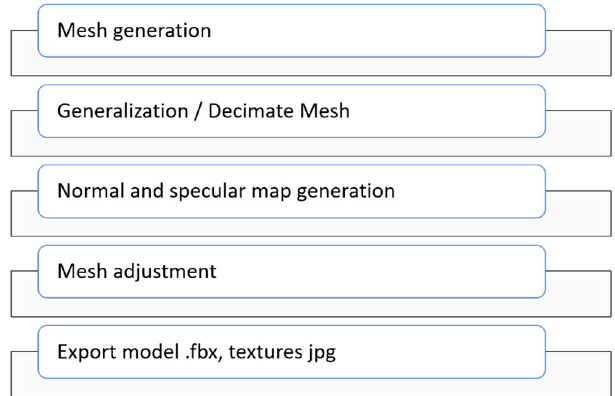
Figure 11. Methodology used for creating 3D models. Table 4. Main characteristics of the 3D models.